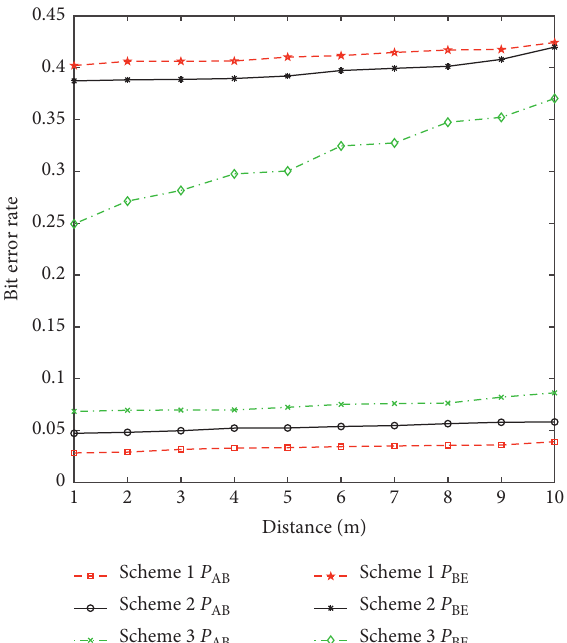
Figure 6: Analysis of the variation of the secret key random pa- rameter bit error rate with